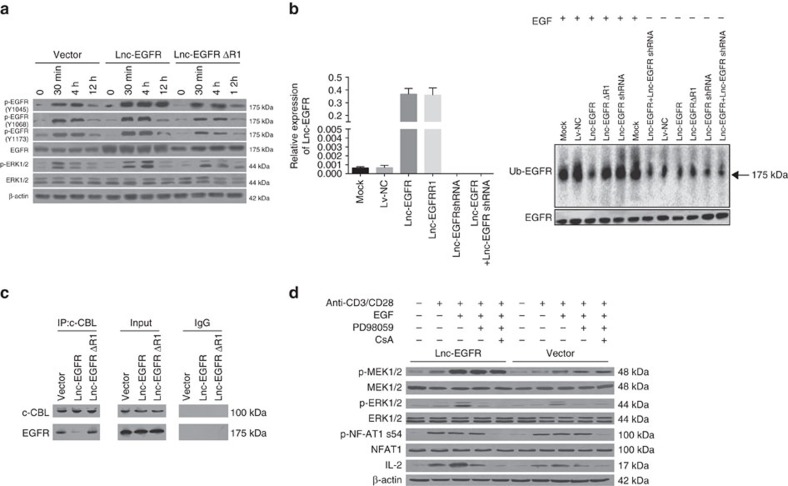
Lnc-EGFR prevents the ubiquitination of EGFR by binding to Tyr1045.(a) T cells isolated from peripheral blood of HCC patients were transduced with indicated lentiviral particles and then treated with with EGF (20 ng ml−1) for indicated timepoints followed by western blotting for p-EGFR(Y1045), p-EGFR(Y1068), p-EGFR(Y1073), p-ERK1/2(T202/Y204), EGFR, ERK1/2 and β-actin. (b) Normal, healthy human T cells transduced with mock or indicated lentiviral particles were determined with real-time PCR (upper) and were further treated with EGF (100 ng ml−1) for 90 min or left untreated. Whole-cell lysates were prepared and EGFR was immunoprecipitated followed by western blotting for ubiquitin. Equal loading of EGFR was determined by western blotting via anti-EGFR antibodies (lower). (c) Whole-cells lysates were prepared and c-CBL was immunoprecipitated via anti-c-CBL antibody. The presence of EGFR in the immunecomplex was determined by western blotting via anti-EGFR antibody. (d) Transduced T cells were treated with anti-CD3/anti-CD28 beads (bead-to-cell ratio of 1:1), EGF (20 ng ml−1) or left untreated in the presence or absence of PD98059 (40 μM) and/or CsA (1 μM). Whole-cell lysates were prepared and subjected to Western blotting for p-ERK1/2(T202/Y204), p-MEK1/2(S217/221), p-NF-AT1(S54), ERK1/2, IL-2, MEK1/2 and β-actin. Each experiment was performed triplicated.